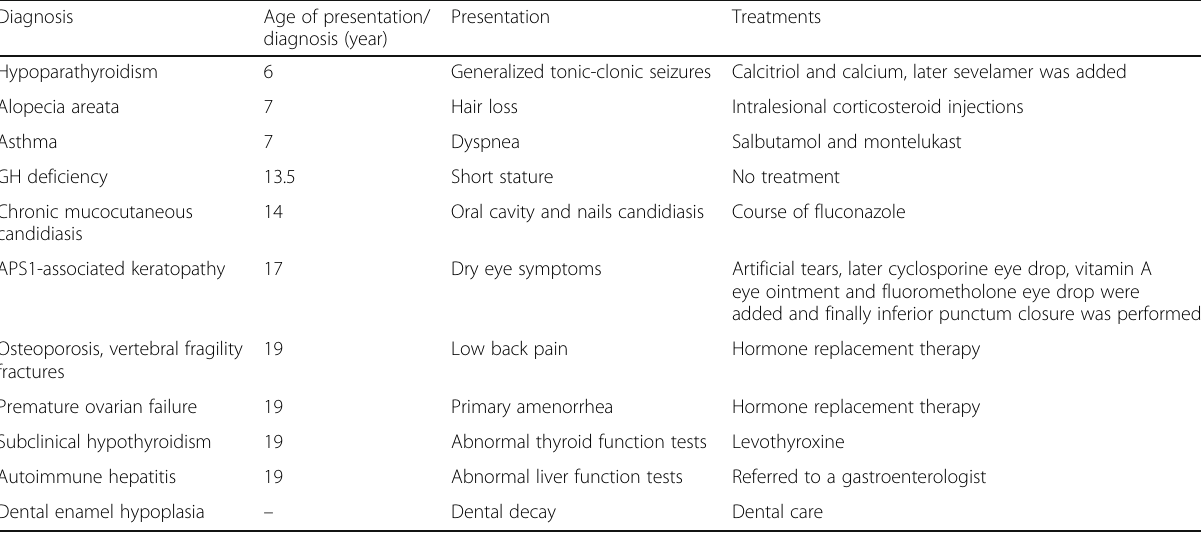
Table 1 Patient ’ s clinical